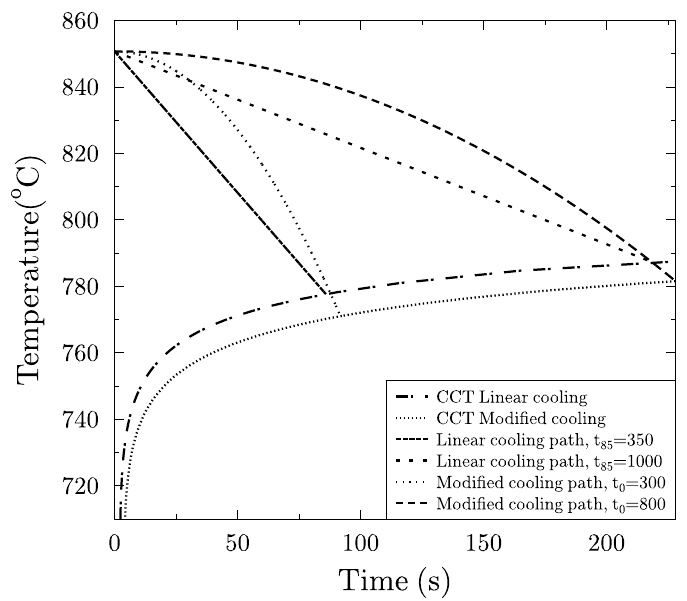
Figure 6. Phase transformation start calculated for two different types of cooling paths: (1) the linear cooling paths exemplified by linear plots and (2) the modified cooling paths given by the Equation T ( t ) = A e3 ( 1 − ( t / t 0 ) 2 ) shown by the curved